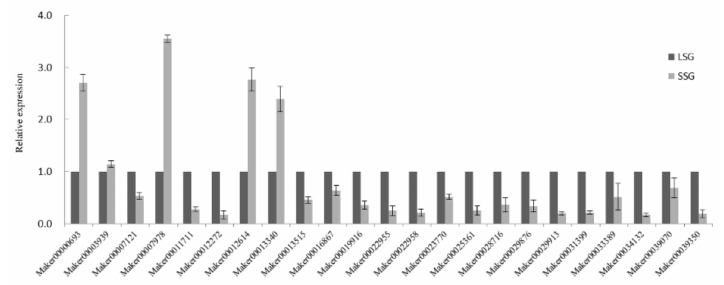
Figure 5. qRT-PCR analysis of DEGs related to sponge gourd fruit